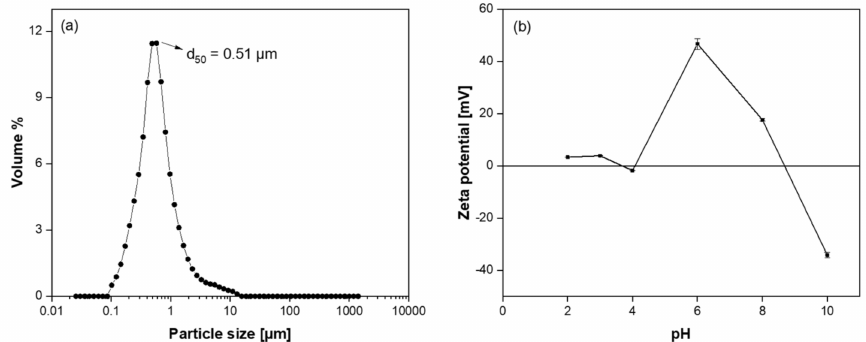
Figure 2. ( a ) Particle size distribution of the coating suspension and ( b ) Zeta potential as a function of pH at the surface of the diluted